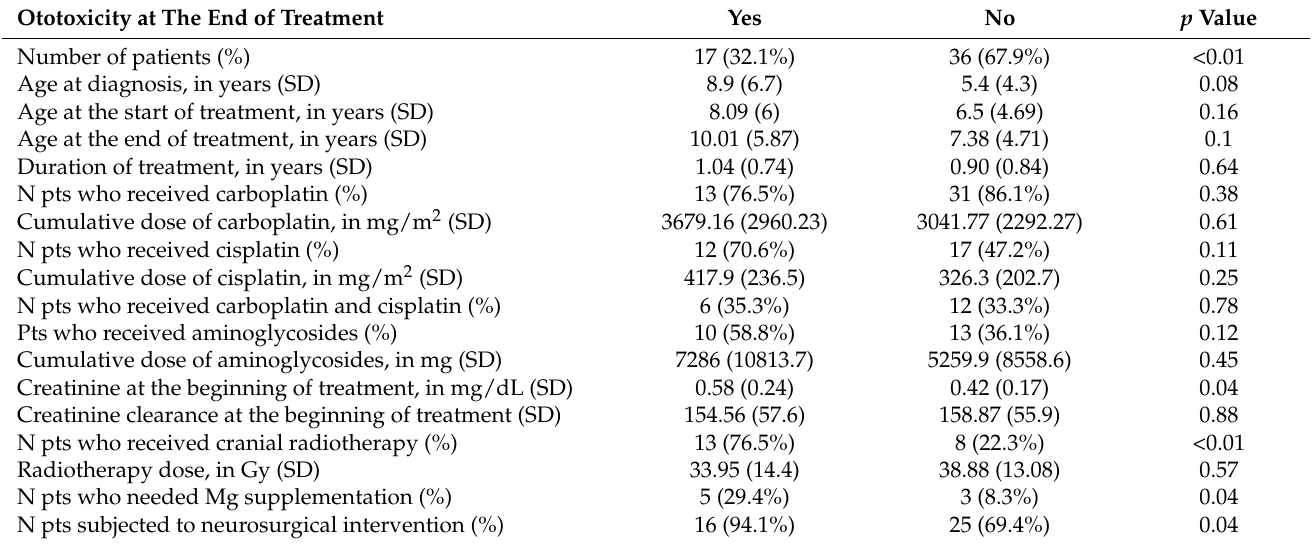
Table 2 compares the presence of risk factors for the onset of ototoxicity between the group of patients with ototoxicity and patients with normal hearing at the end of treatment. Table 2. Comparison between patients with hearing impairment and patients with normal hearing at the end of